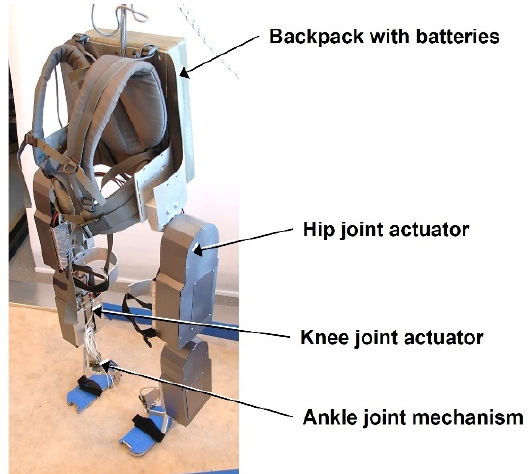
Figure 2. The orthotic robot designed and manufactured at the Division of Design of Precision Devices at the Faculty of Mechatronics, the Warsaw University of Technology.